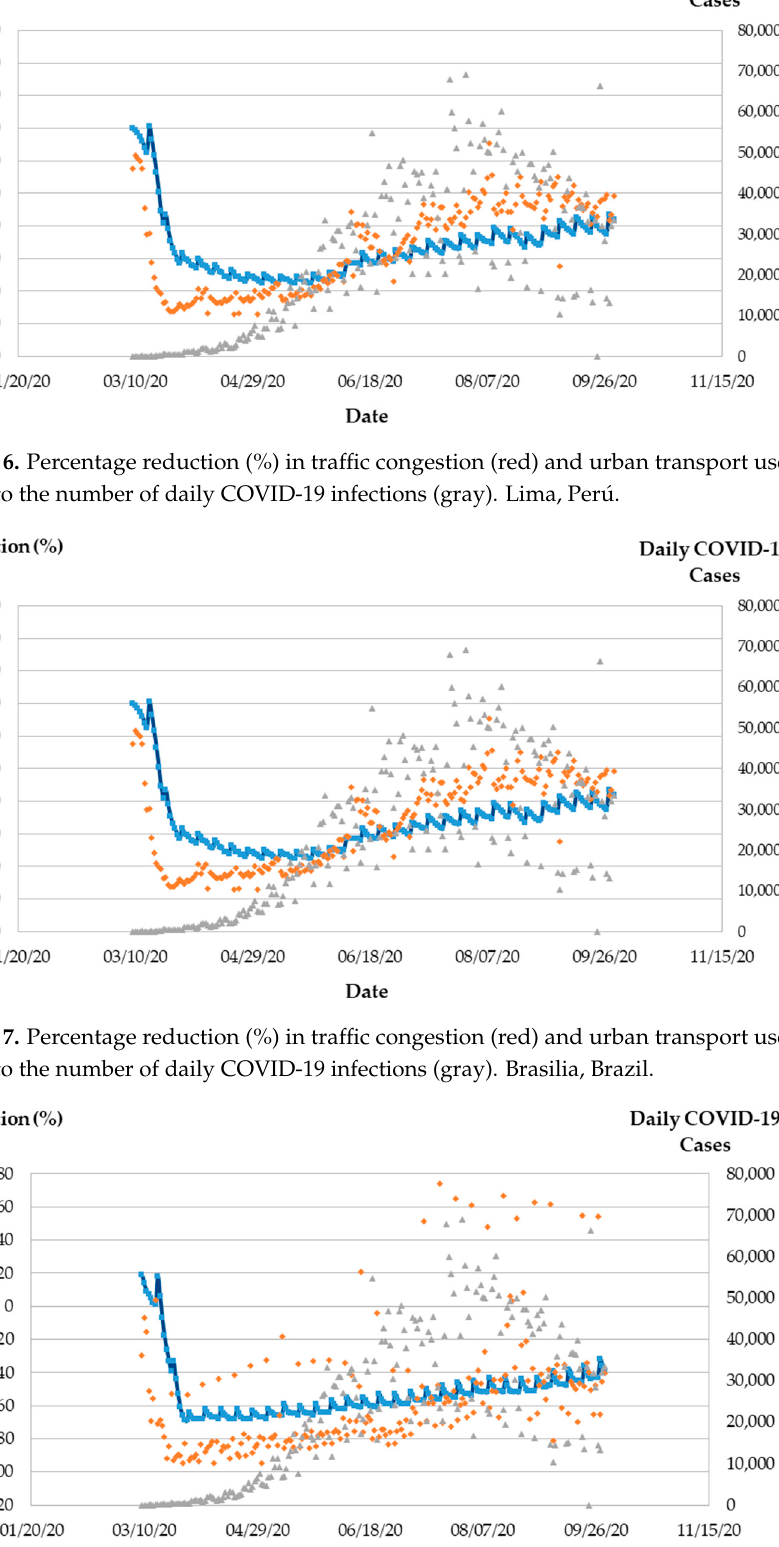
Figure 8. Percentage reduction (%) in traffic congestion (red) and urban transport use (blue), com- pared to the number of daily COVID-19 infections (gray). Sao Paulo, Brazil.